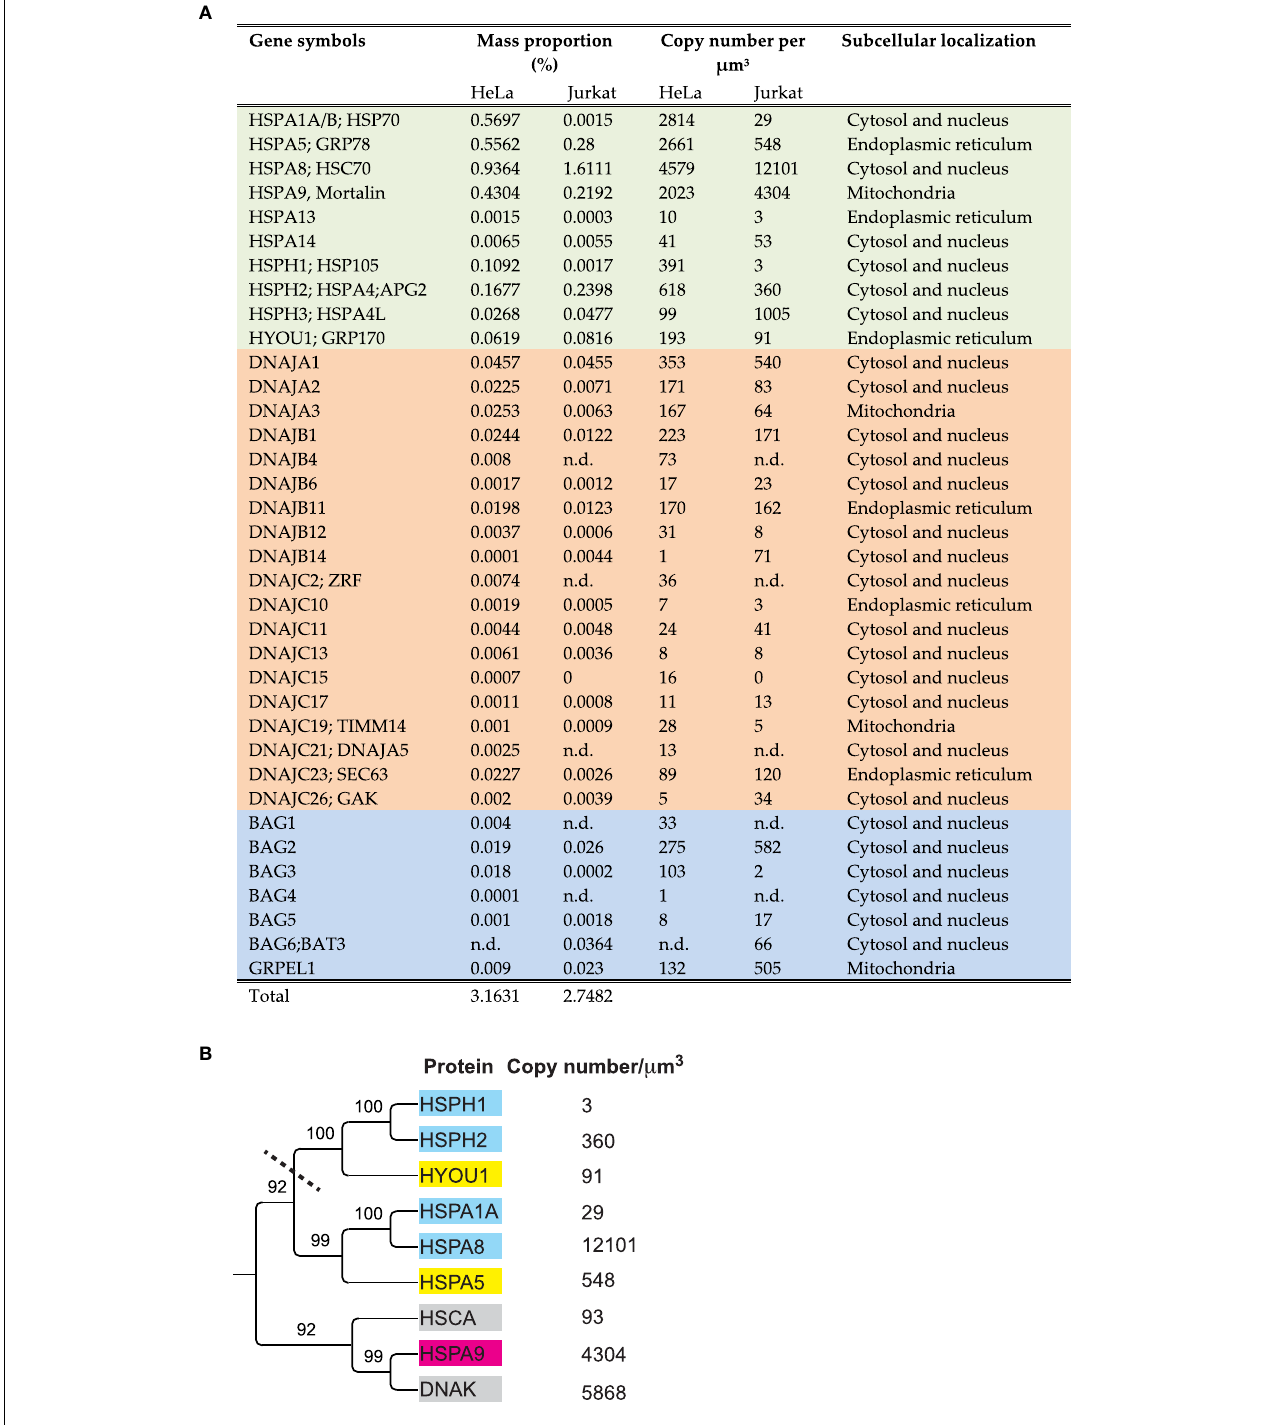
HSP70 and HSP110 proteins in Jurkat cells, using E. coli DnaK and HSCA as out-groups. Presumed subcellular localization: CYT; cytoplasmic (cyan), ER; Endoplasmic reticulum (yellow). MIT; mitochondria (magenta). The copy number per micron cube are from human (Jurkat) cells (Finka and Goloubinoff, 2013; Finka et al., 2015) and from E. coli (gray) (Arike et al.,